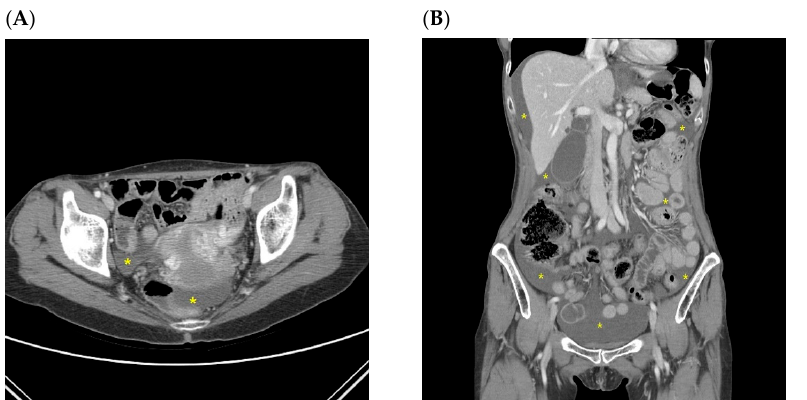
Figure 3. CT images of a patient on initial recurrence of malignant ascites without other CT findings related to peritoneal seeding, later confirmed by cytology. A small volume of pelvic ascites fluid was observed at first appearance ( A ). Follow-up CT ( B ) showed an increased volume of ascites fluid. Yellow stars indicate